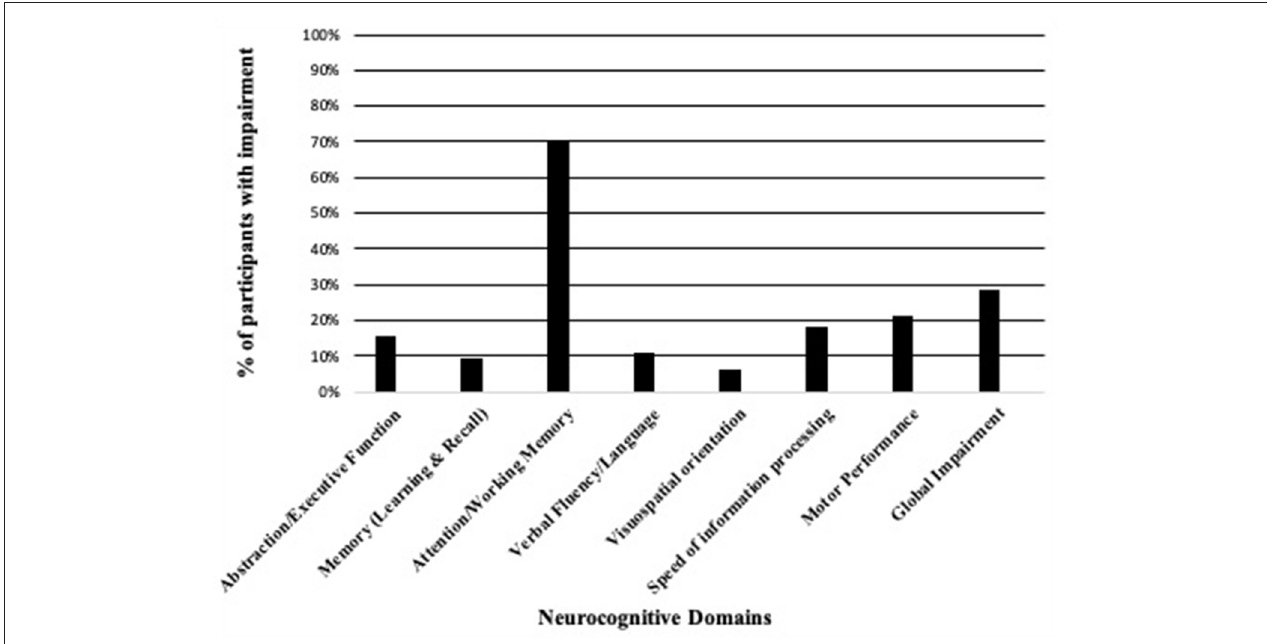
FIGURE 1 | Neurocognitive domain impairment among PWH ( N = 144).